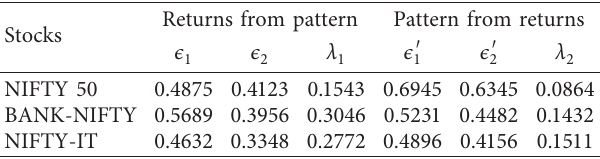
Table 12: Average prediction error reduction index of NSE indices for the period 2010–2020. Returns from Stocks